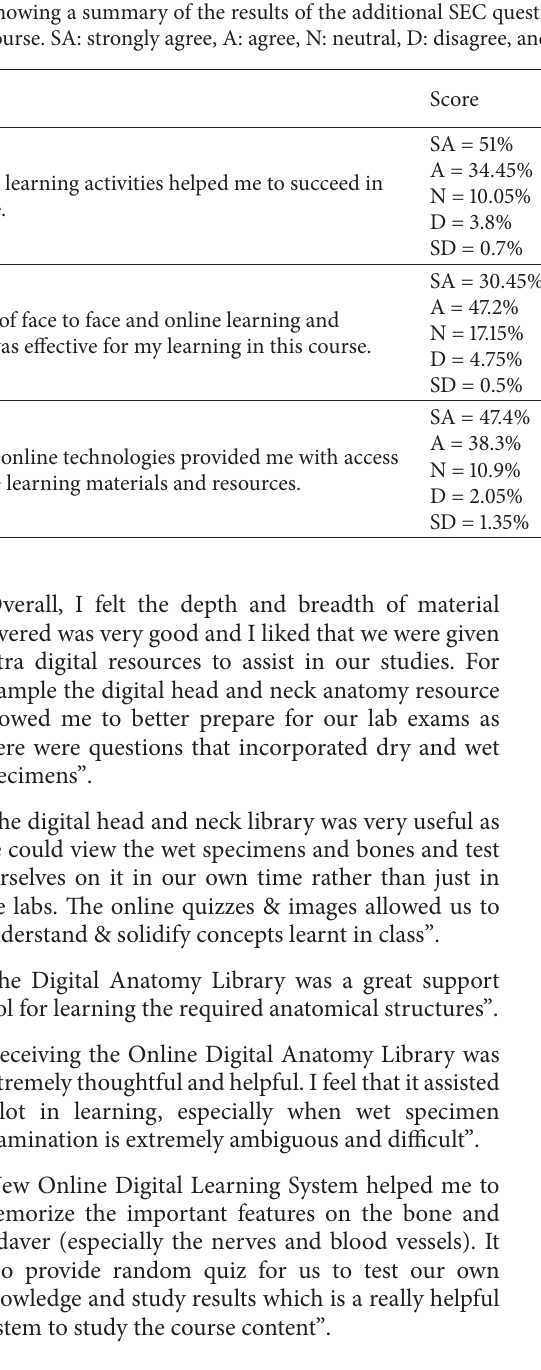
% +ve Median Std deviation Mean % − ve SA =